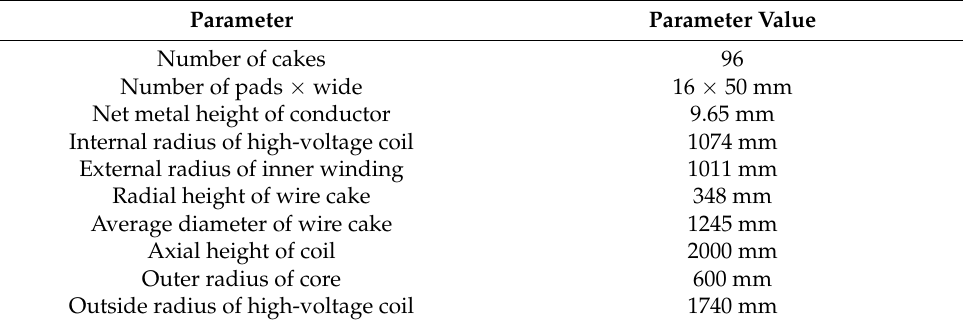
Figure 2. Winding structure of the transformer. Table 1. Structural dimension parameters of high-voltage windings.